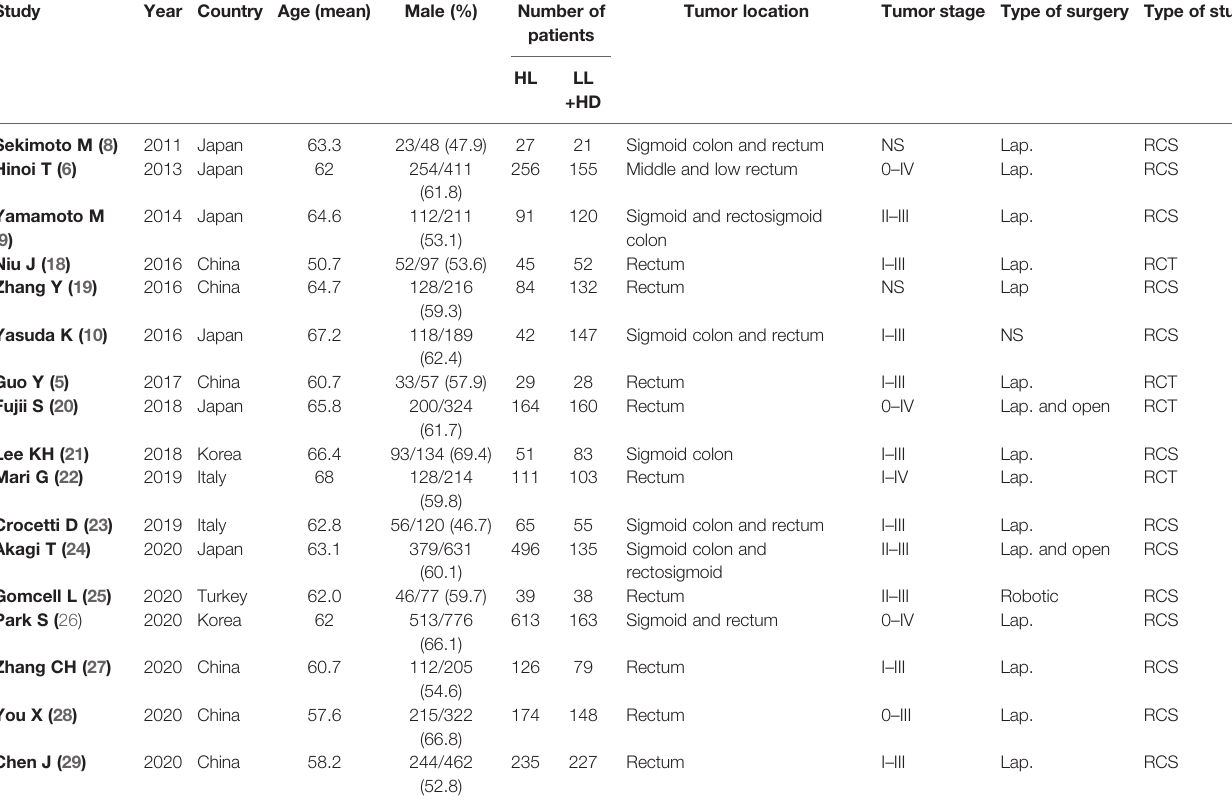
TABLE 1 | Characteristics of the studies included in this meta-analysis.